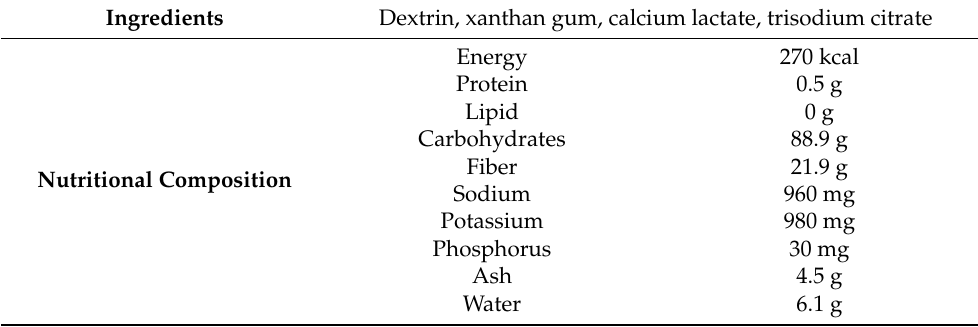
Table 1. Batch used for the study, nutritional composition and ingredients of Tsururinko Quickly.